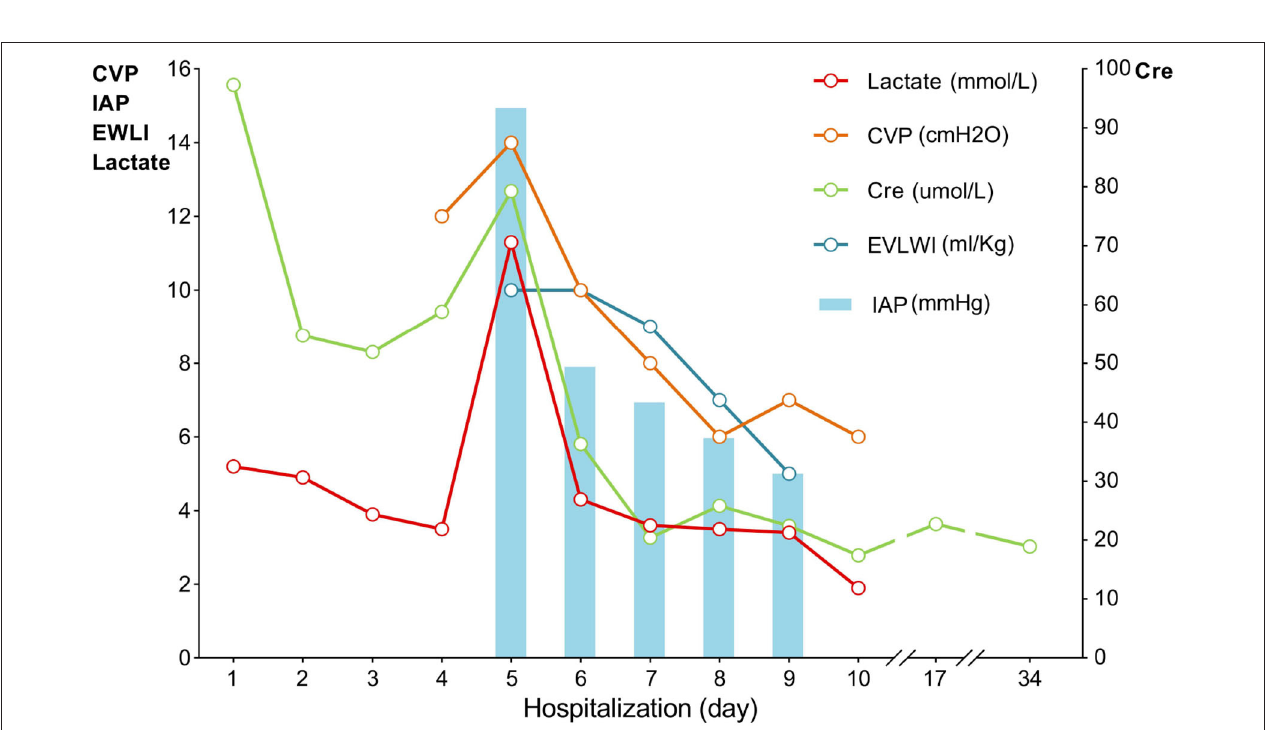
FIGURE 2 | Trends of vital parameters during hospitalization. CVP, central venous pressure; IAP, intra-abdominal pressure; EVLWI, extravascular lung water index; Lac, lactate, Cre, serum creatinine.